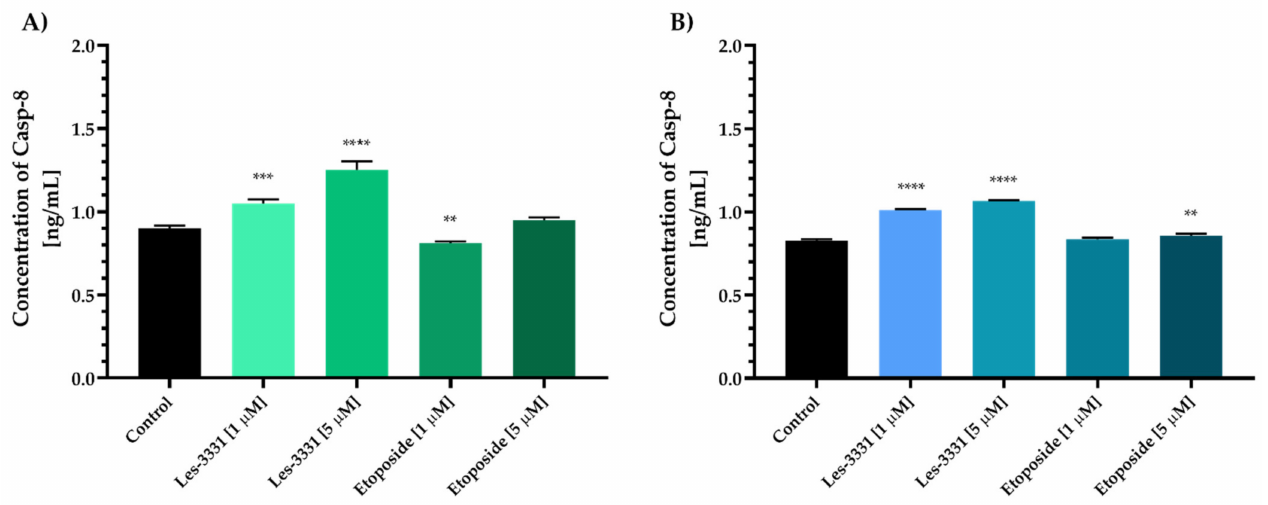
Figure 7. The concentration of Caspase-8 in MCF-7 ( A ) and MDA-MB-231 ( B ) human breast cancer cells after 24 h incubation with Les-3331 and reference drug (etoposide) at 1 µ M and 5 µ M concentration. Mean ± SD from three independent experiments performed in duplicate is presented. Statistical signifi- cance was calculated using one-way ANOVA with Bonferroni multiple comparison test. Differences